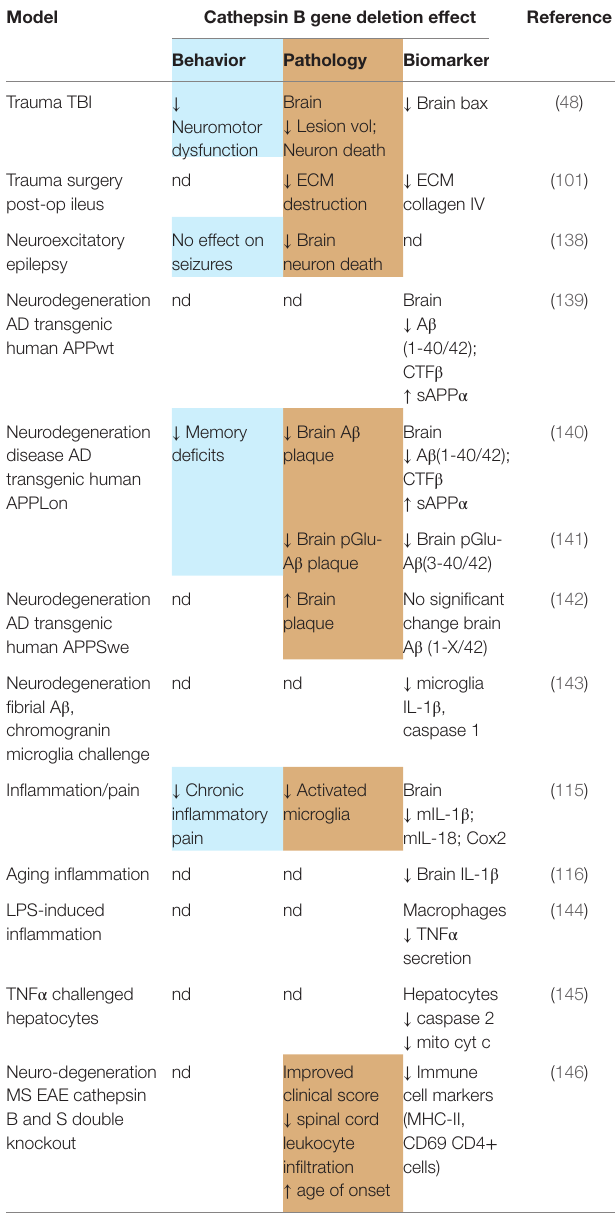
TABLe 3 | Cathepsin B gene deletion improves deficits of TBi and TBi-related animal models.